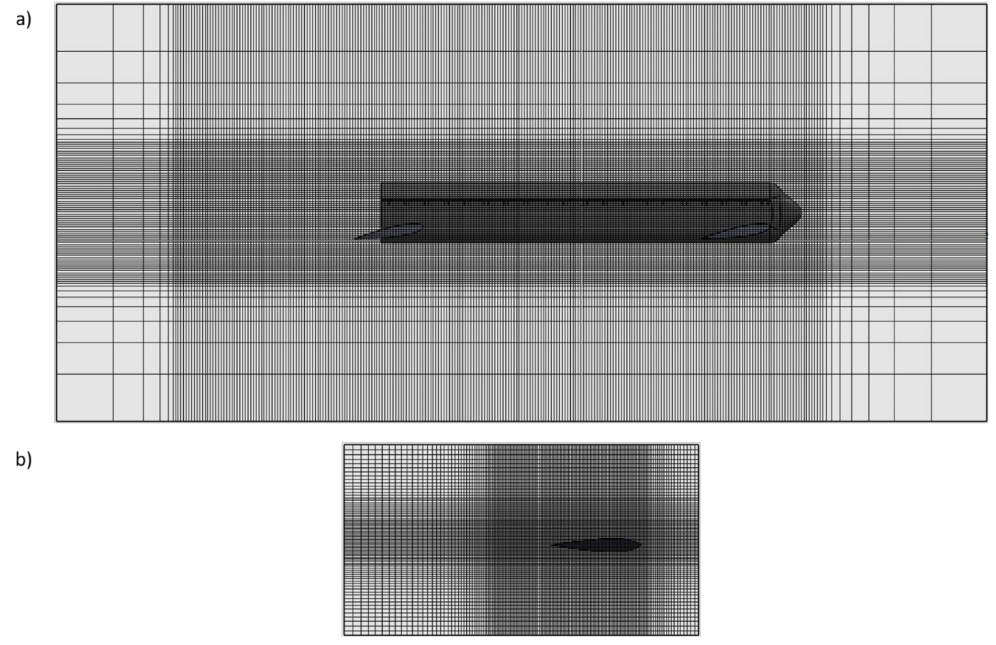
Figure 11. Mesh for fluid-dynamic simulations. ( a ) Whole vehicle in longitudinal cross section view (angle of attack: 10 ◦ ). ( b )